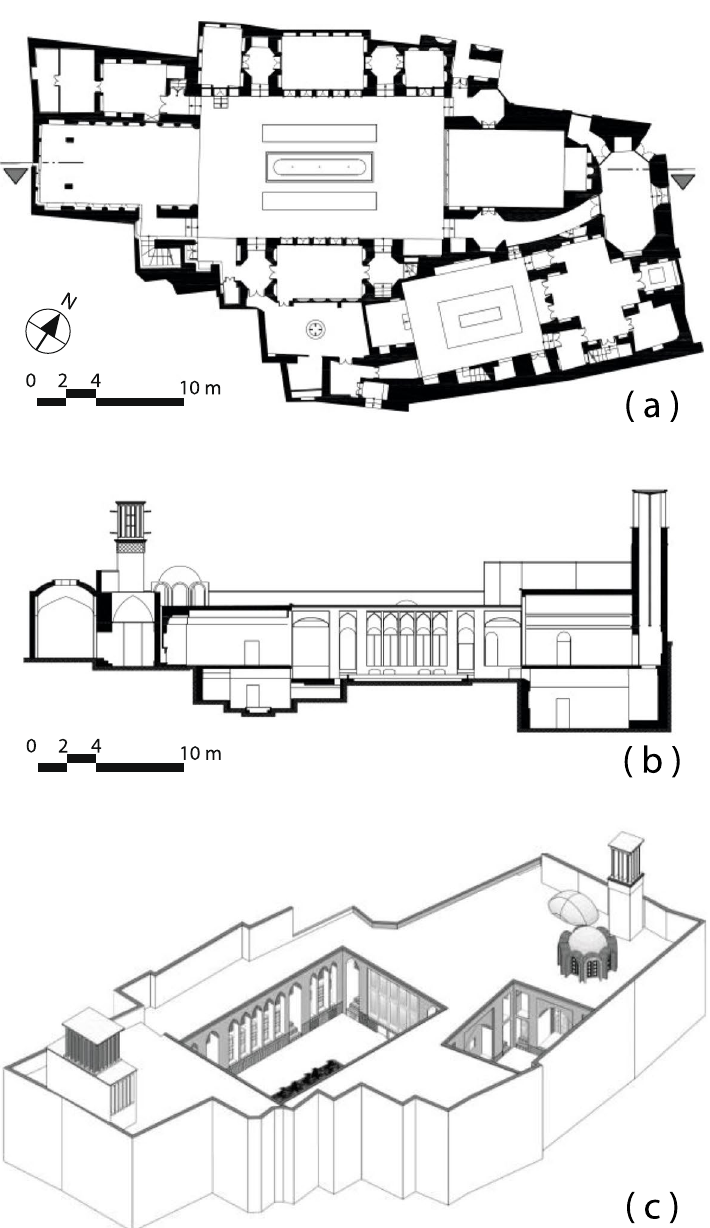
Fig. 2 A typical vaulted adobe house in Yazd: ( a ) plan view, ( b ) cross‑sectional elevation view, and ( c ) perspective view of the Aghayee house (Source: Shamseh Consultant Engineering